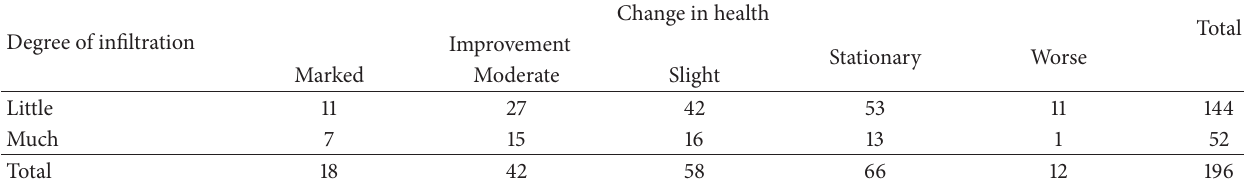
Table 5: 196 patients classified according to change in health and degree of infiltration [12].